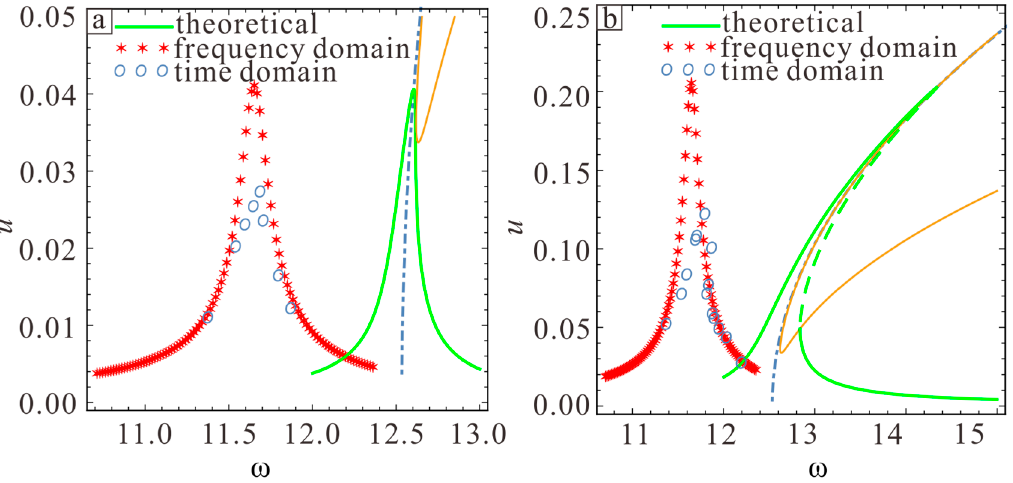
= = and ( b ) 0.1 V ac V .